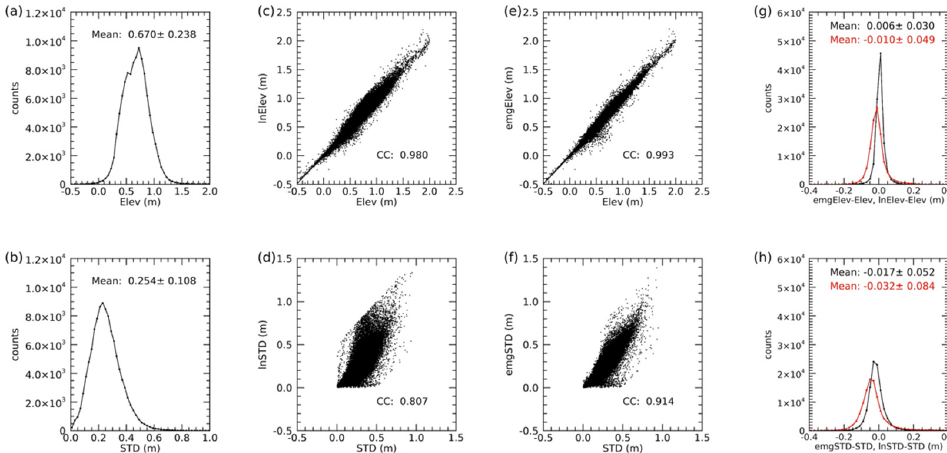
Figure 7. Mean elevation and standard deviation of elevation for each 1.5 km section along-track compared with values calculated from EMG and lognormal fitting parameters. ( a ) 1.5 km mean elevation histogram. ( b ) 1.5 km STD of the elevation histogram. ( c ) Mean elevation (Elev) vs. mean elevation from lognormal model (lnElev). ( d ) STD vs. STD from lognormal model (lnSTD). ( e ) Mean elevation vs. mean elevation from EMG model (emgElev). ( f ) STD vs. STD from EMG model (emgSTD). ( g ) Histograms of emgElev–Elev (black) and lnElev–Elev (red). ( h ) Histograms of emgSTD–STD (black) and lnSTD–STD (red). Measurement noise is removed from STD, lnSTD, and emgSTD.